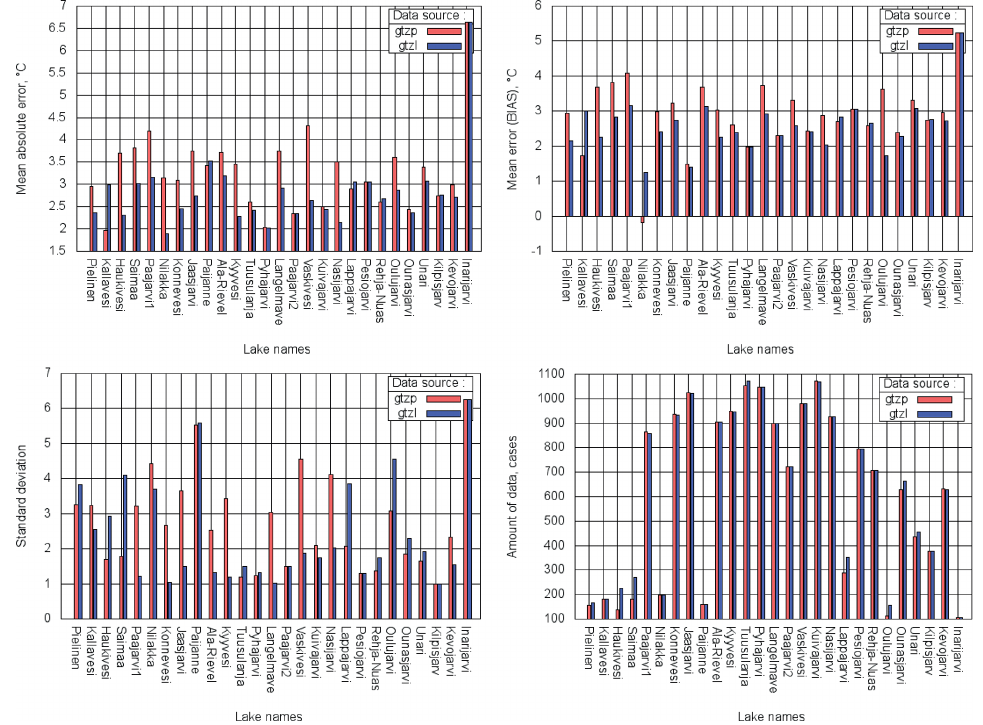
Figure 14. MAE, BIAS, SD and amount of data calculated over all mixing periods 2010–2014 for 27 verification sites; GTZP (red) – experiment with operational D water ; GTZL (blue) – with upgraded D water .